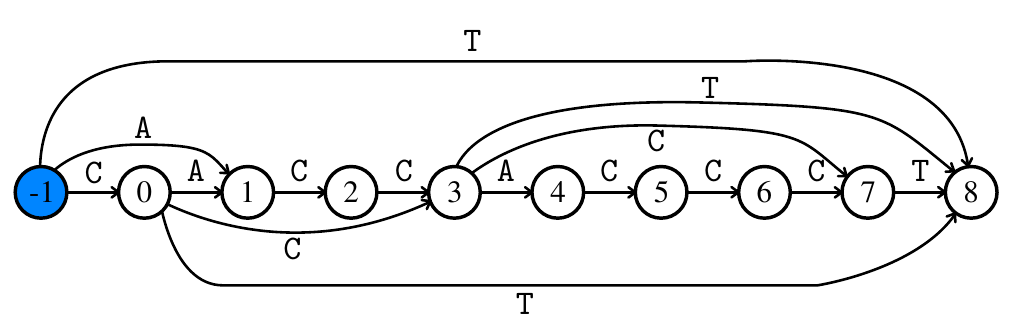
Figure 1. Factor Oracle for x = CACCACCCT , corresponding to pattern p = TCCCACCAC . Omitted edges lead into the omitted FAIL state. The string ACCT is recognized (states 1,2,3,8), although it is not a substring of x